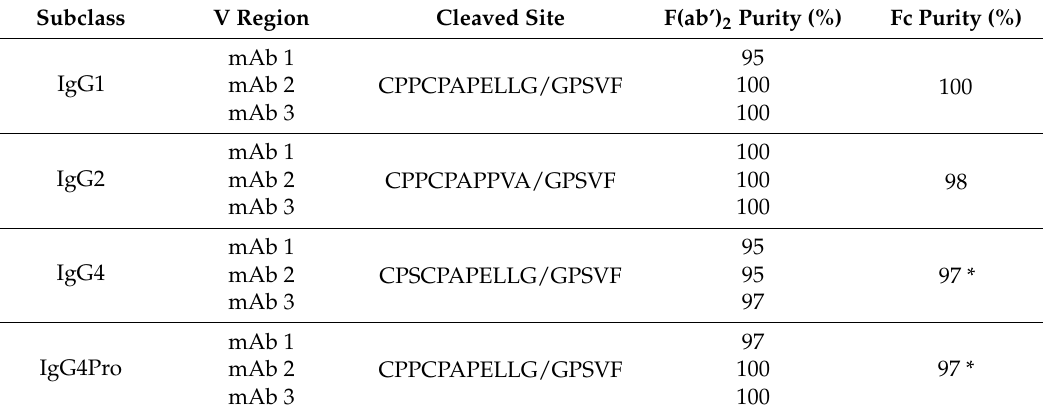
Table 2. Quality of IgG fragments from IdeS digestion.